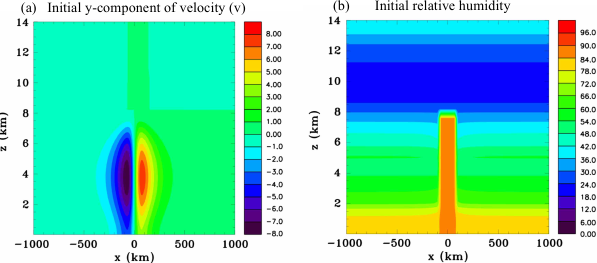
Figure 13. Vertical sections for Experiment 11: the radiation scheme activated in the whole domain with a mid-level vortex